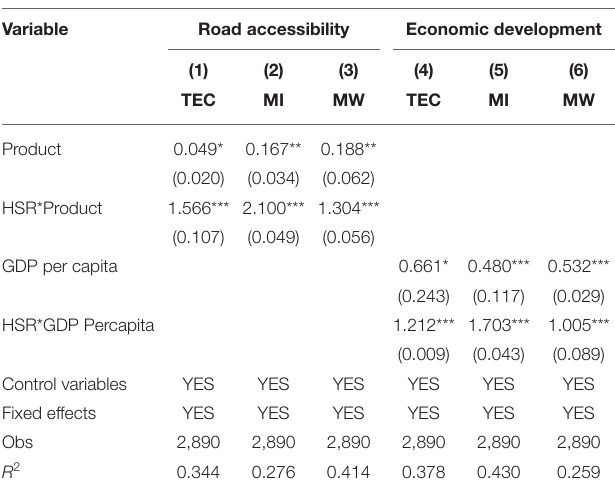
TABLE 3 | Mechanism test. TABLE 4 | Parallel trend